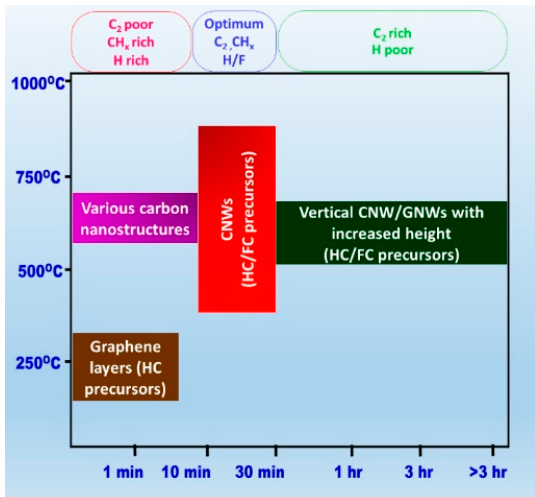
Figure 9. Figure 9. Summary of time–temperature growth regimes for the initial growth of different carbon nanostructures.